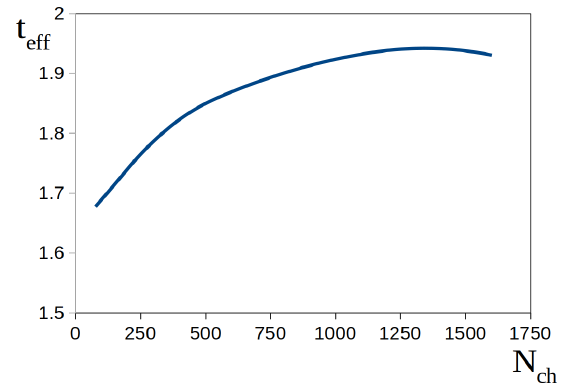
Figure 15. Dependence of efficient string tension t eff on multiplicity. Our model calculations for √ Pb - Pb collisions at s = 2.76